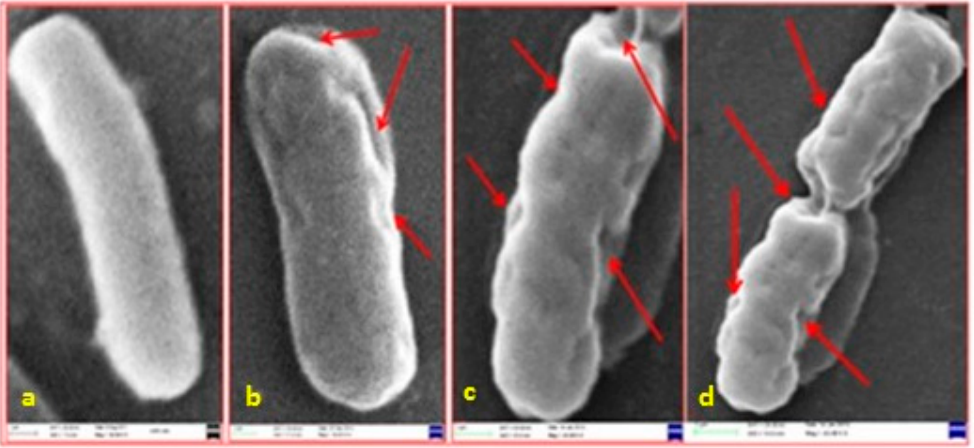
Figure 2. SEM photomicrographs of E. coli : ( a ) control; and ( b ) 10; ( c ) 20; and ( d ) 30 μ g·mL − 1 gum arabic capped Ag NPs (arrows indicate depressions and extensive damage of bacterial cells). Reproduced with permission from John Wiley and Sons [23].